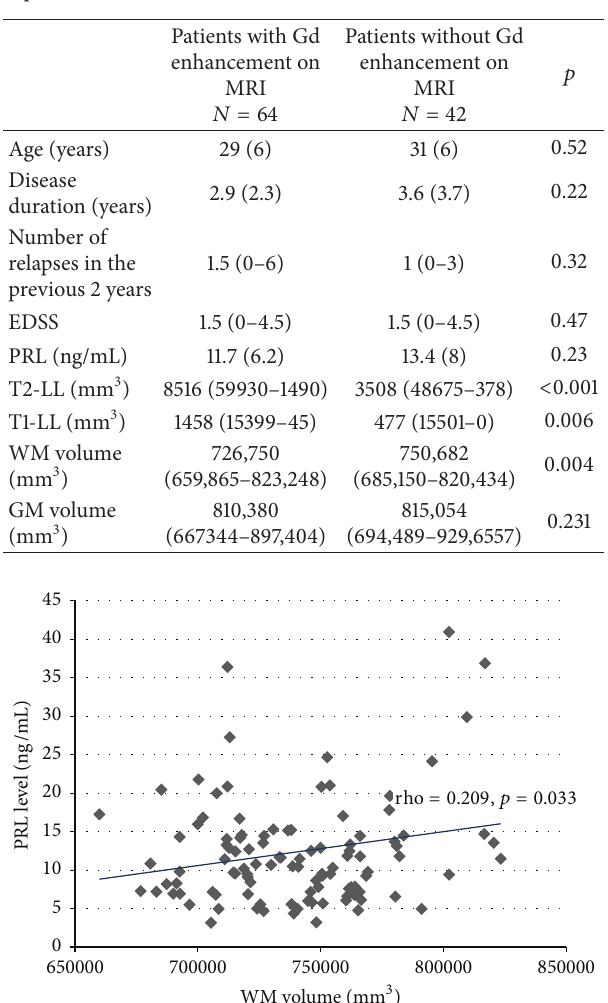
Table 1: Demographical and MRI data of patients according to the presence of Gd enhancement on MRI. All values are expressed as median (range) except for age and disease duration that are expressed as mean (SD).